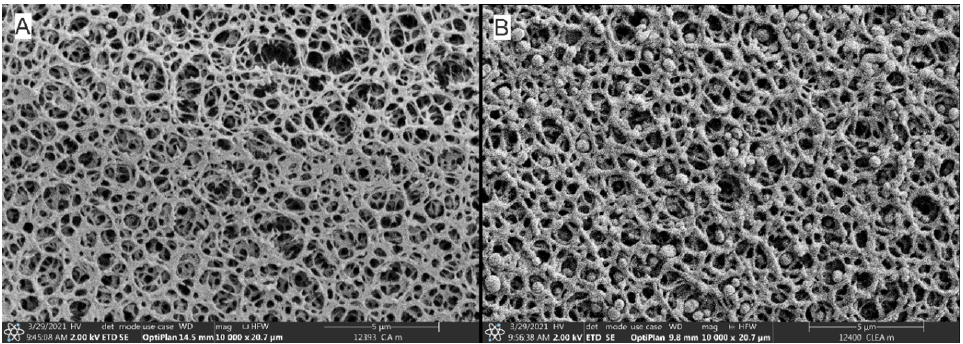
Figure 7. Scanning Electron Microscopy images of the cellulose acetate membrane before ( A ) and after ( B ) immobilization in 10,000 times magnification.